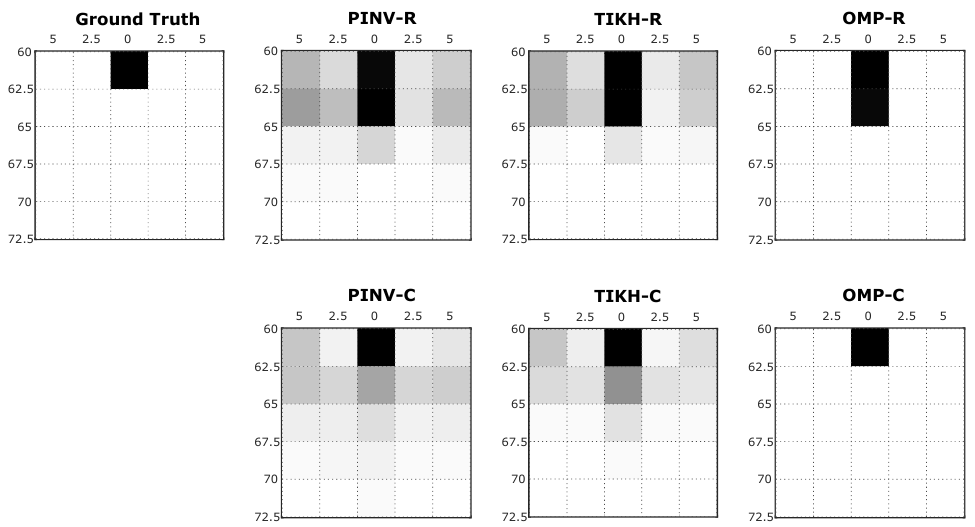
Figure 7. Examples of reconstructed images with a single obstacle in the